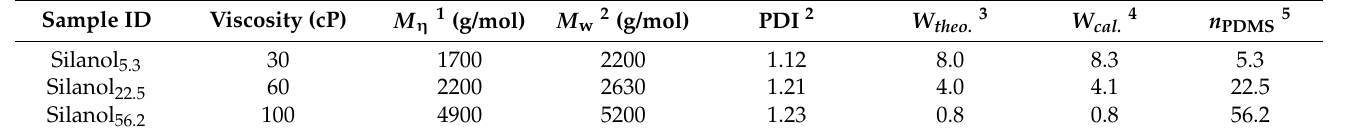
Table 1. Basic information of silanol-terminated PDMS with different chain